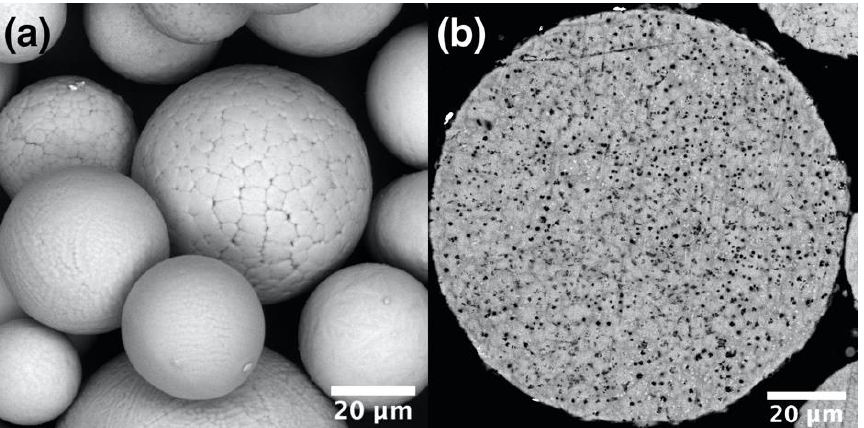
Figure 2. SEM images of the mechanically alloyed plasma spheroidized (MAPS) powder showing ( a ) surface morphology and ( b ) cross-section of a particle.